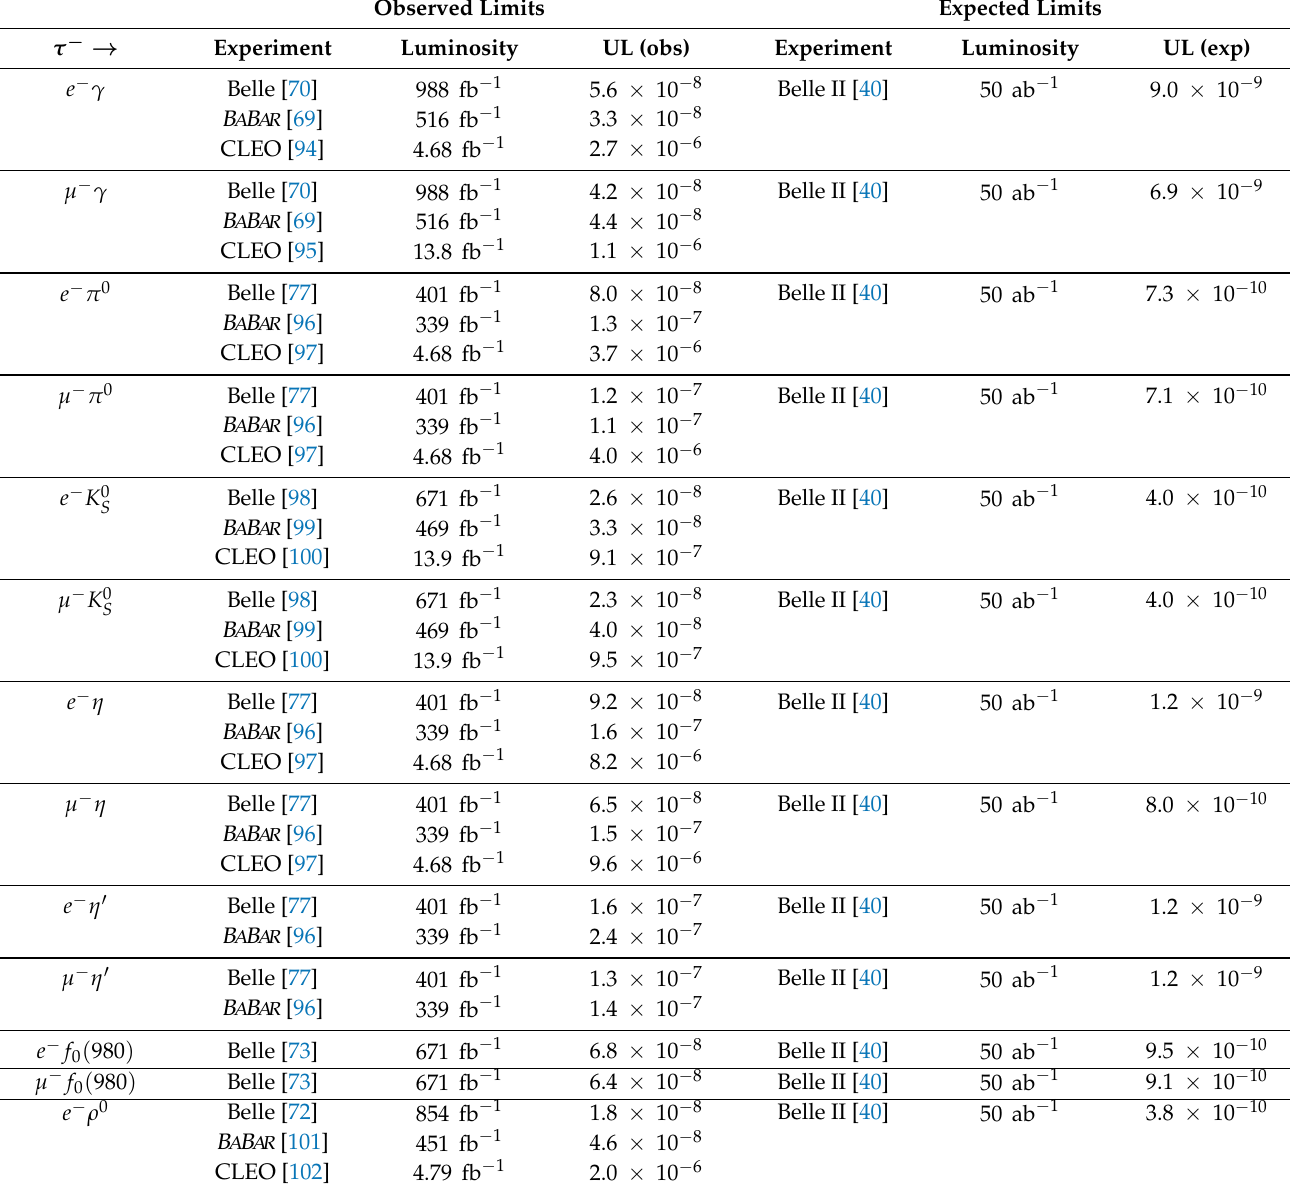
Table 4. Current status of observed (obs) and expected (exp) upper limits (UL) [40,75]. Observed